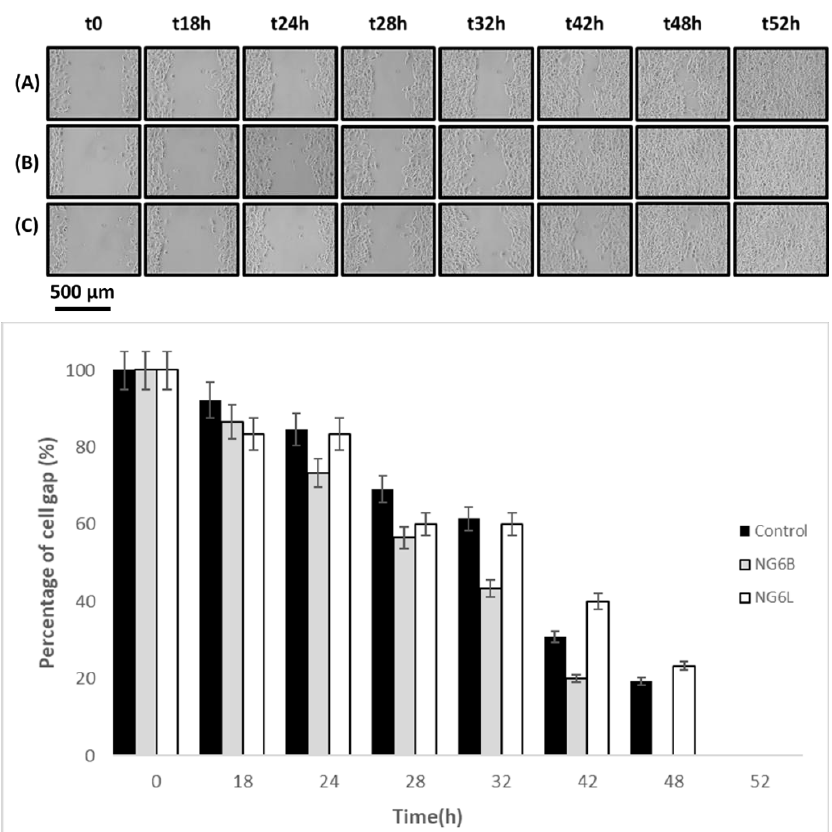
Figure 4. Berberine release profile from nanogels (NG6L formulation) recorded in saline solution using dialysis membranes setup (n = 3, mean ± sd).